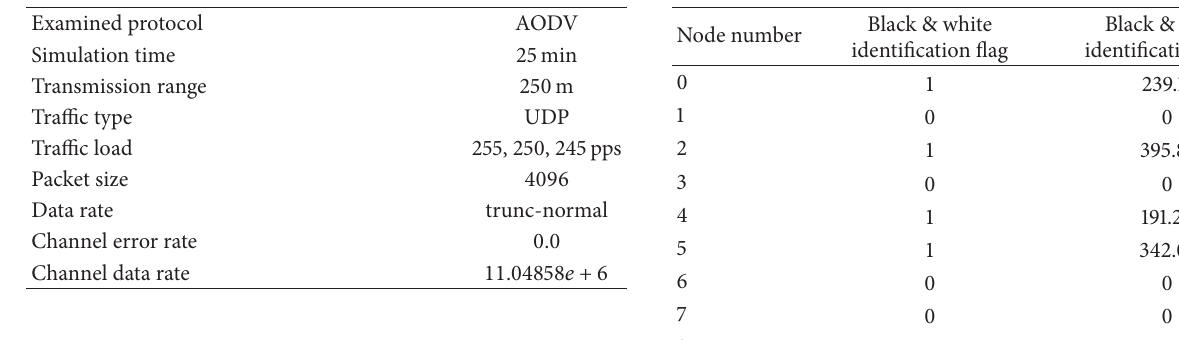
Table 1: Simulation parameters for cluster head selection. Table 2: Routing table with Black- and White